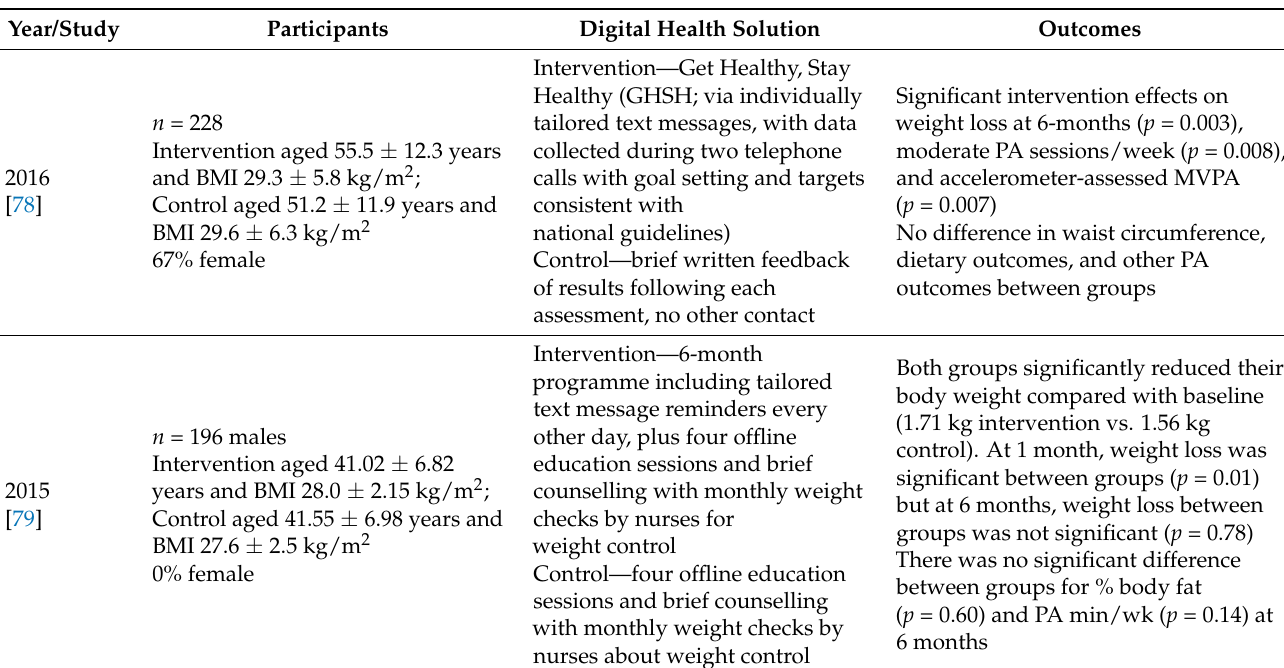
Table 4. Study characteristics for the use of tailored text/phone